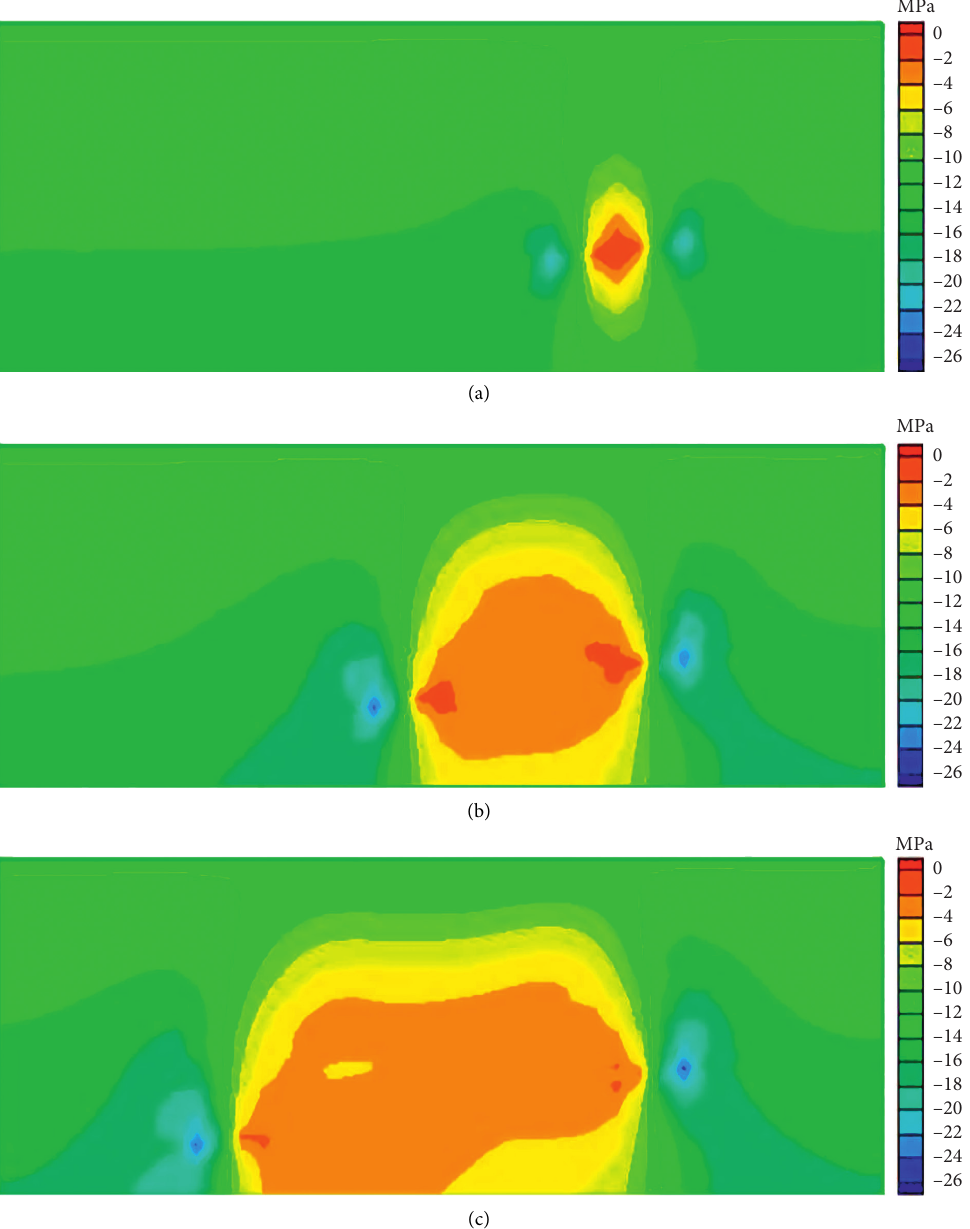
Figure 4: Vertical stress distribution along the inclined direction in the mining of the rock-coal composite protective layer. (a) Working face is advanced to 40m; (b) working face is advanced to 120m; (c) working face is advanced to 200